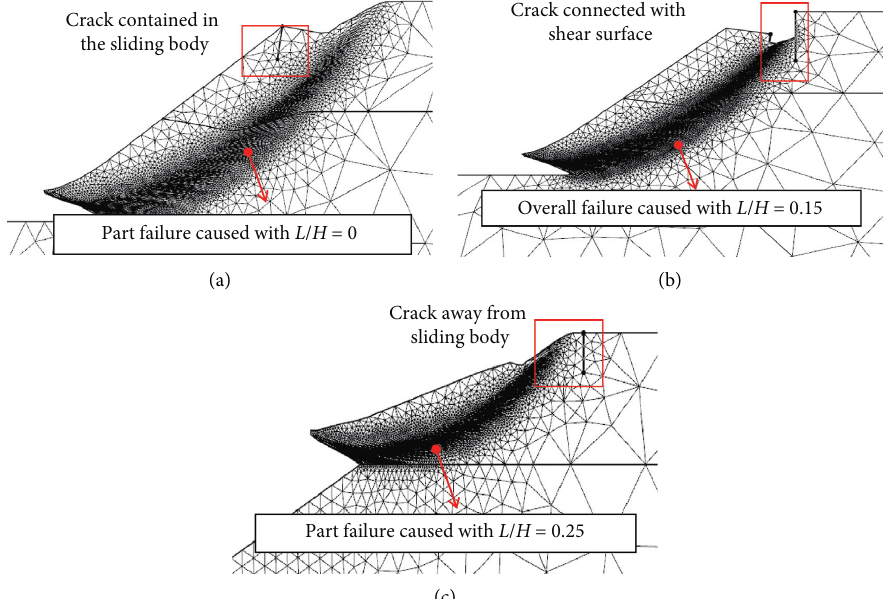
Figure 14: Failure modes of slope under different distances between crack and slope. (a) D/H � 0. (b) D/H � 0.15. (c) D/H �